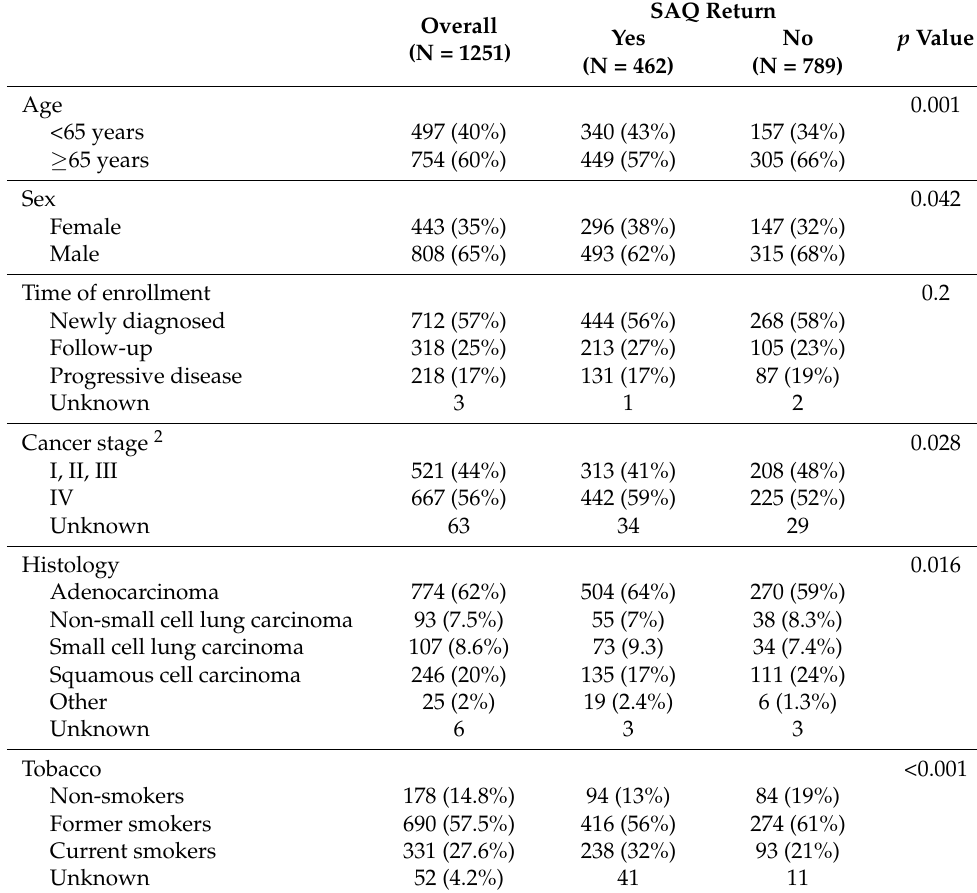
Table 4. Characteristics of the PROPOUMON national patients per SAQ 1 return status, 2017–2019,